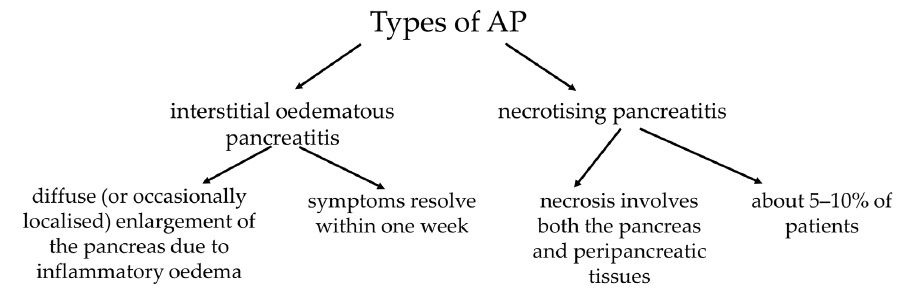
Figure 1. Types of acute pancreatitis [15,26].